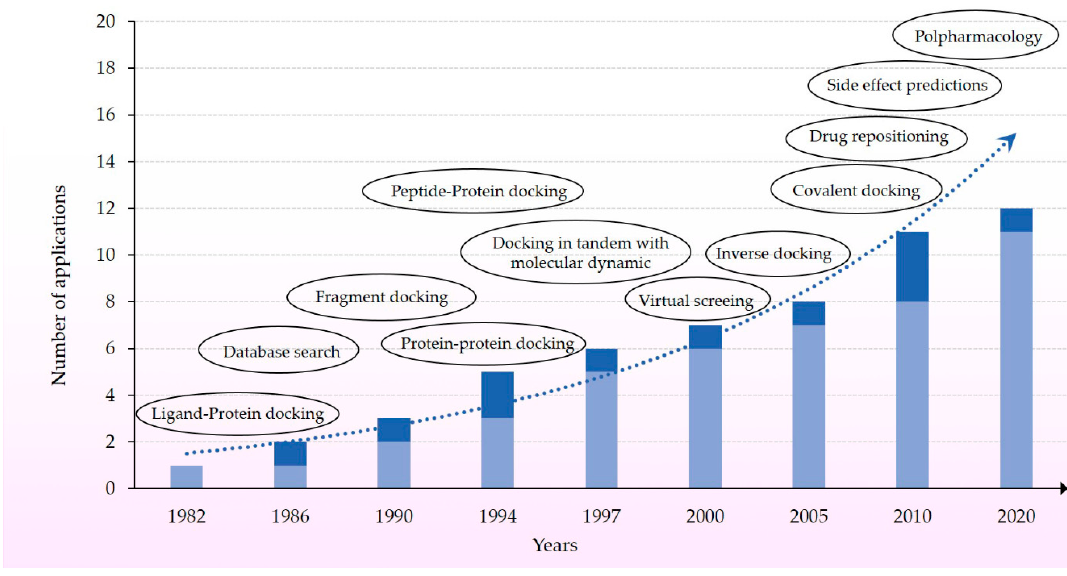
Figure 2. Increase of molecular docking applications. The dark blue compartment shows the new applications that are summed up with the existing ones. applications that are summed up with the existing